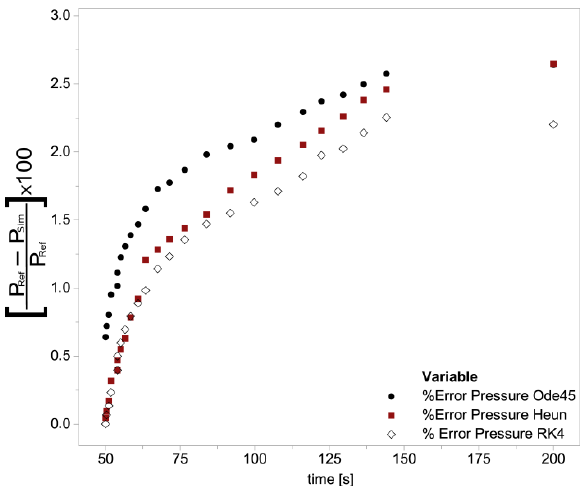
Figure 12. The approximation error for the total volume of water in the boiler with respect to the reference volume.